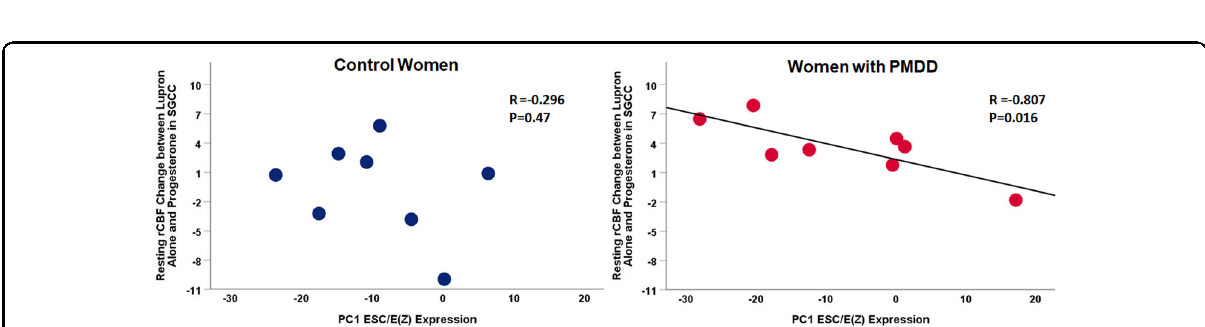
Fig. 3 Relationship between ESC/E(Z) gene expression and the difference in SGCC resting rCBF activity between Lupron alone and progesterone add-back conditions. Pearson correlations between the fi rst principle component of baseline LCL ESC/E(Z) gene expression and the difference in SGCC resting rCBF activity between the progesterone add-back and Lupron-alone conditions in healthy control women (left) and women with PMDD (right). In women with PMDD, the fi rst principle component of the ESC/E(Z) expression signi fi cantly correlated with the change in resting rCBF between Lupron-alone and progesterone add-back conditions (Pearson r = − 0.807, P = 0.016), whereas no correlations were observed in healthy controls (Pearson r = − 0.296, P =